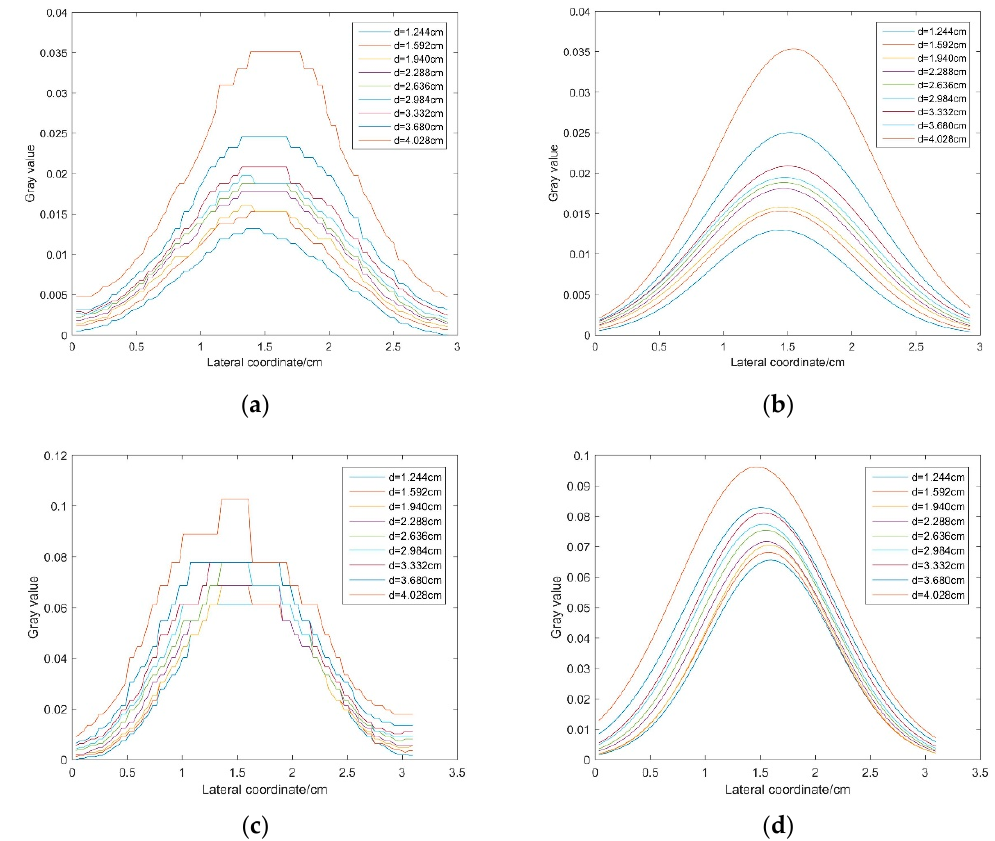
Figure 7. ( a ) Dose distribution measured with PAGAT and ( b ) its Gaussian fitting results of different slices; ( c ) dose distribution measured with MAGAT-f and ( d ) its Gaussian fitting results of different slices. Table 5. Gaussian fitting results at different depths.